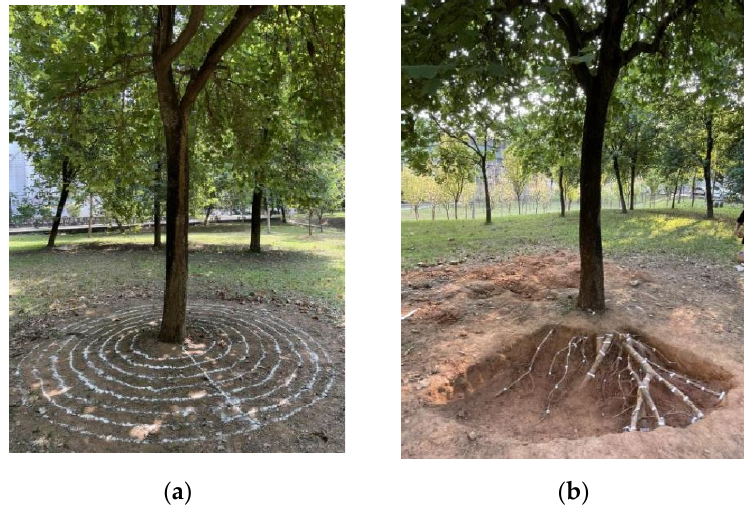
Figure 8. Field test: ( a ) detection route; ( b ) root excavation for verification.